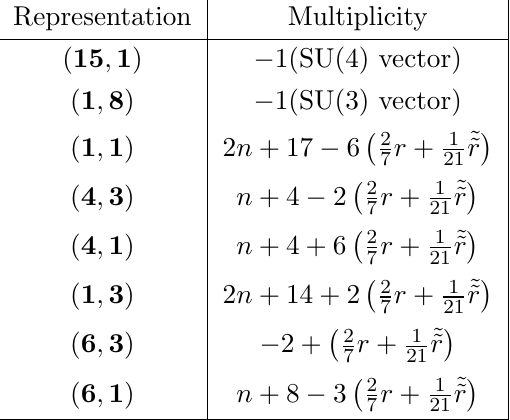
Table 12 . The spectrum for the con(cid:12)guration